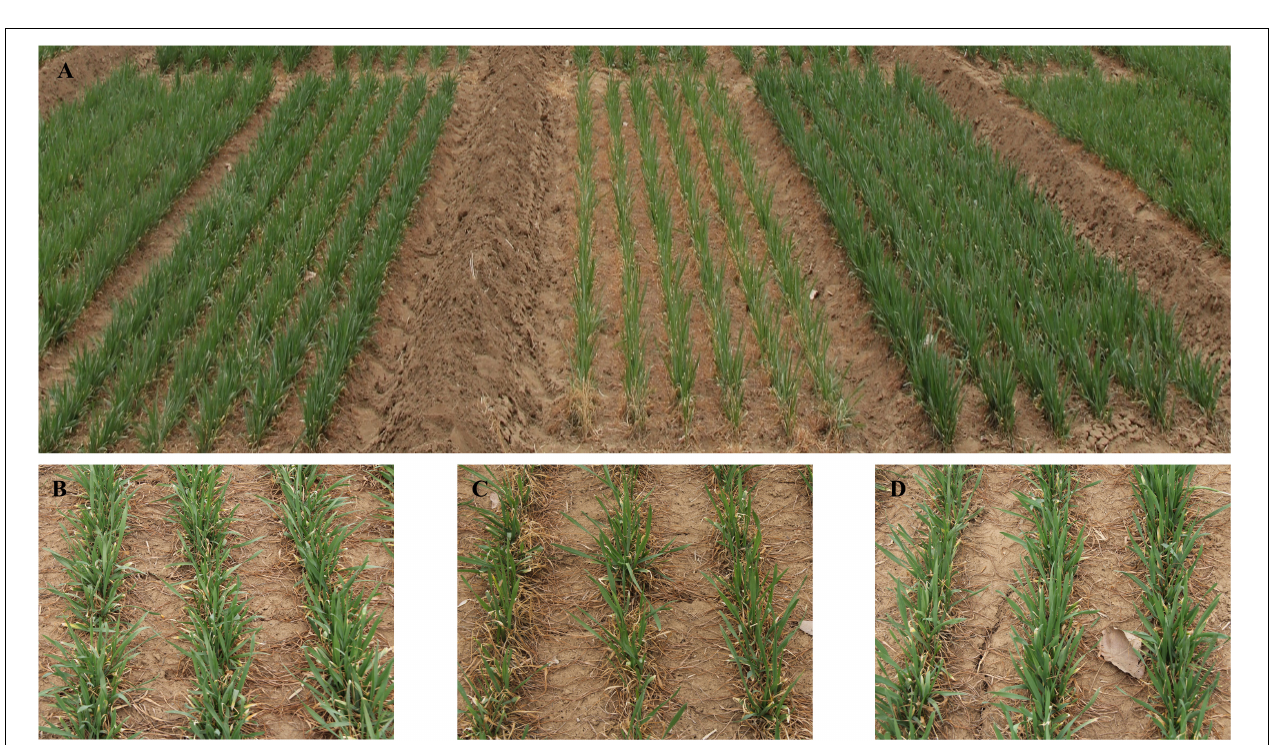
FIGURE 5 | Performances of winter frost tolerance for wheat cultivar Lunxuan 103 and its parents Shijiazhuang 8 and Shimai 12 at 2018SY. (A) Plot performances of Shijiazhuang 8, Shimai 12, and Lunxuan 103 (from left to right) and partial performances of Shijiazhuang 8 (B) , Shimai 12 (C) , and Lunxuan 103 (D) .